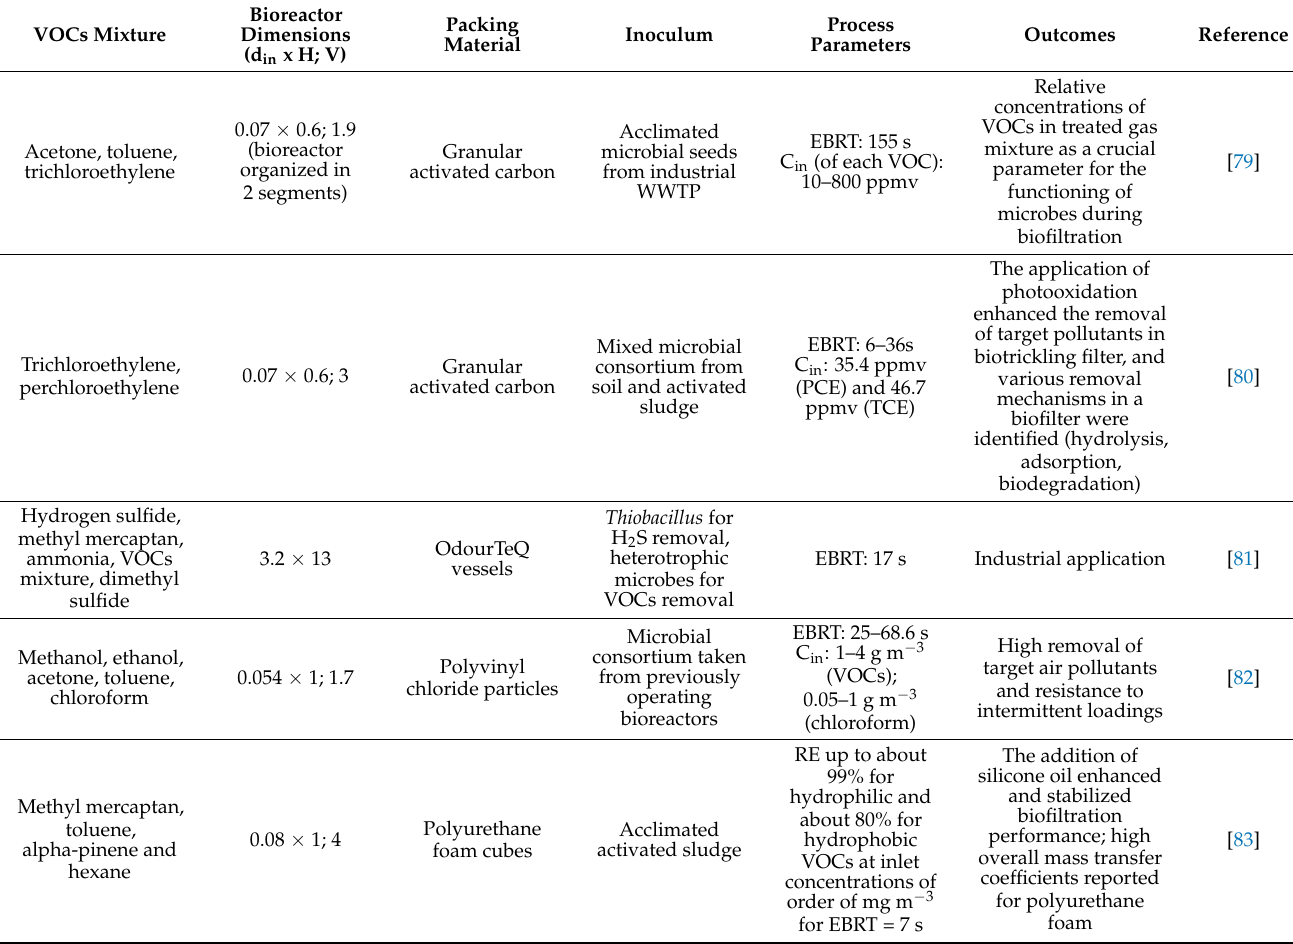
Table 3. Selected research on biotrickling filtration of VOCs